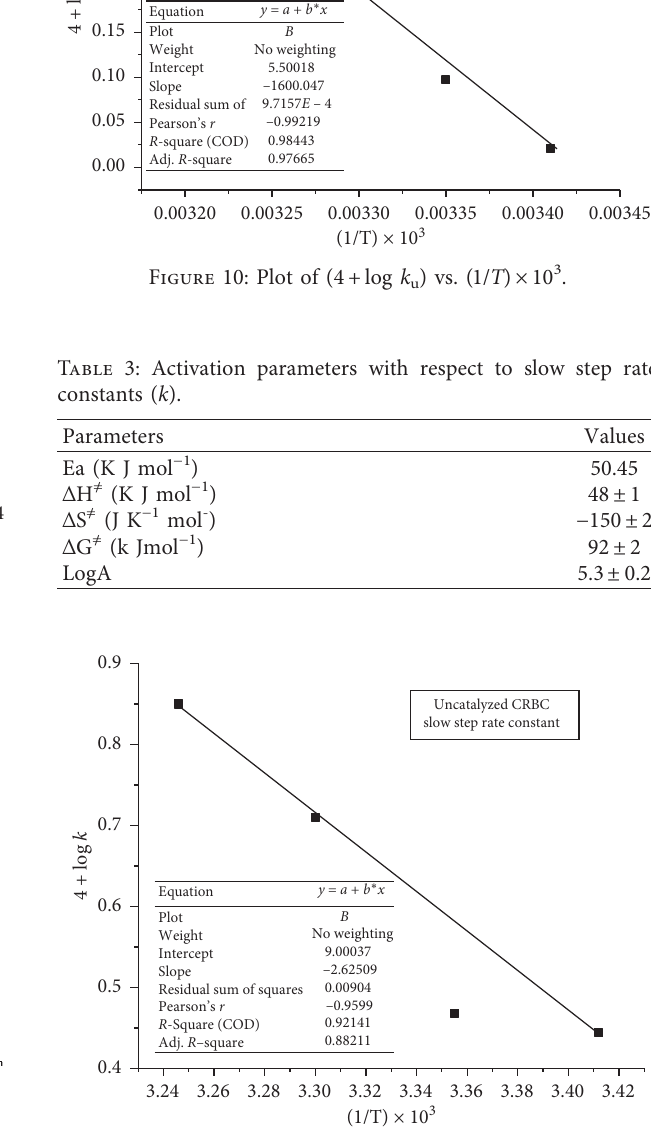
u ) vs. 4 +log [CRBC].